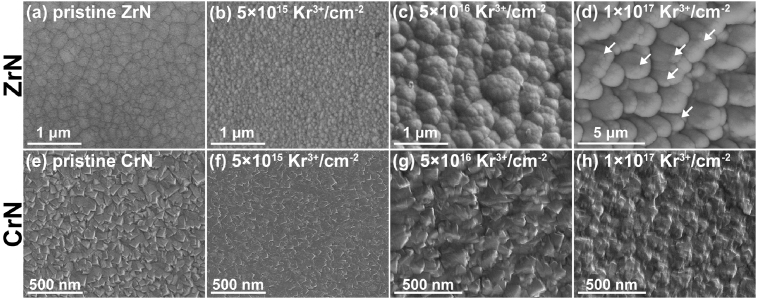
The surface SEM images of the ZrN and CrN coatings with respect to the fluence of the Kr3+ ion irradiation. (a) pristine ZrN, (b) 5×1015 Kr3+/cm−2 on ZrN, (c) 5×1016 Kr3+/cm−2 on ZrN, (d) 1×1017 Kr3+/cm−2 on ZrN, (e) pristine CrN, (f) 5×1015 Kr3+/cm−2 on CrN, (g) 5×1016 Kr3+/cm−2 on CrN, (h) 1×1017 Kr3+/cm−2 on CrN.